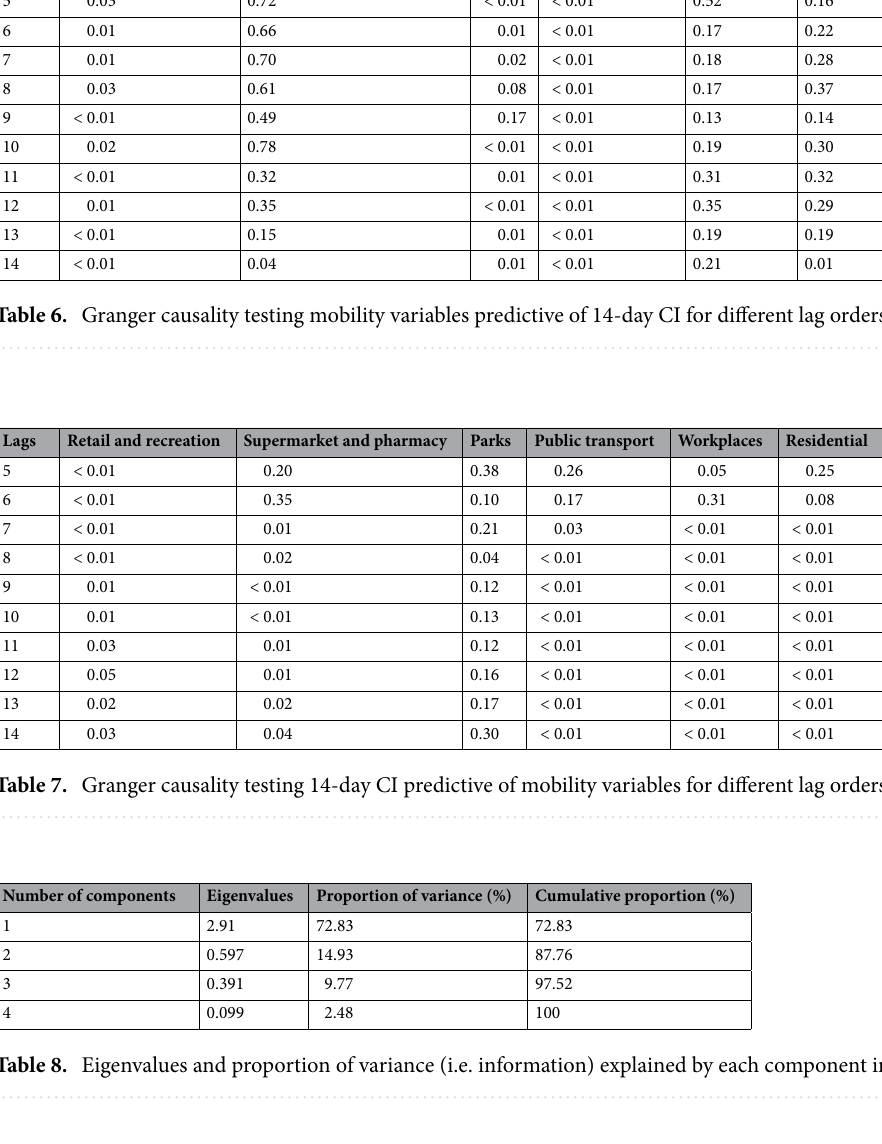
Table 8. Eigenvalues and proportion of variance (i.e. information) explained by each component in the PCA.